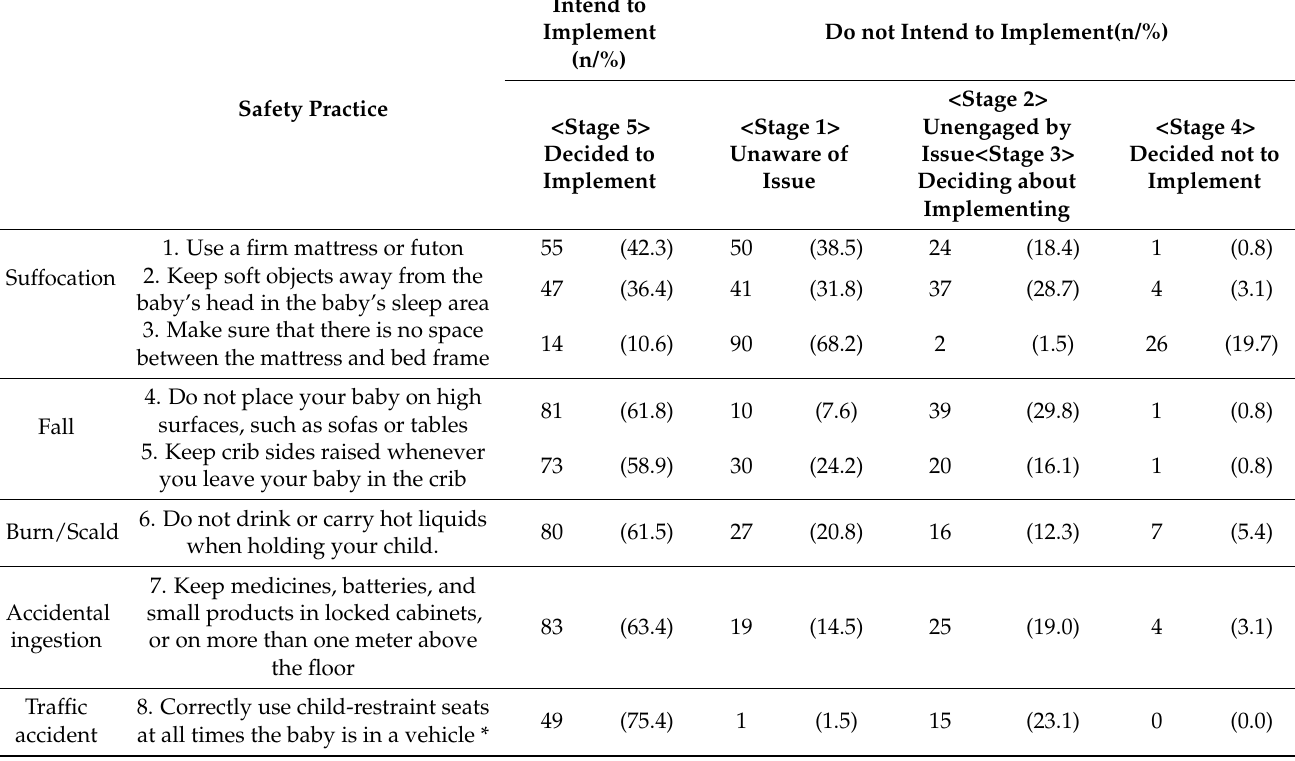
Table 1. Participants’ Intention to Implement Safety Practices to Prevent Infant Injuries (n =